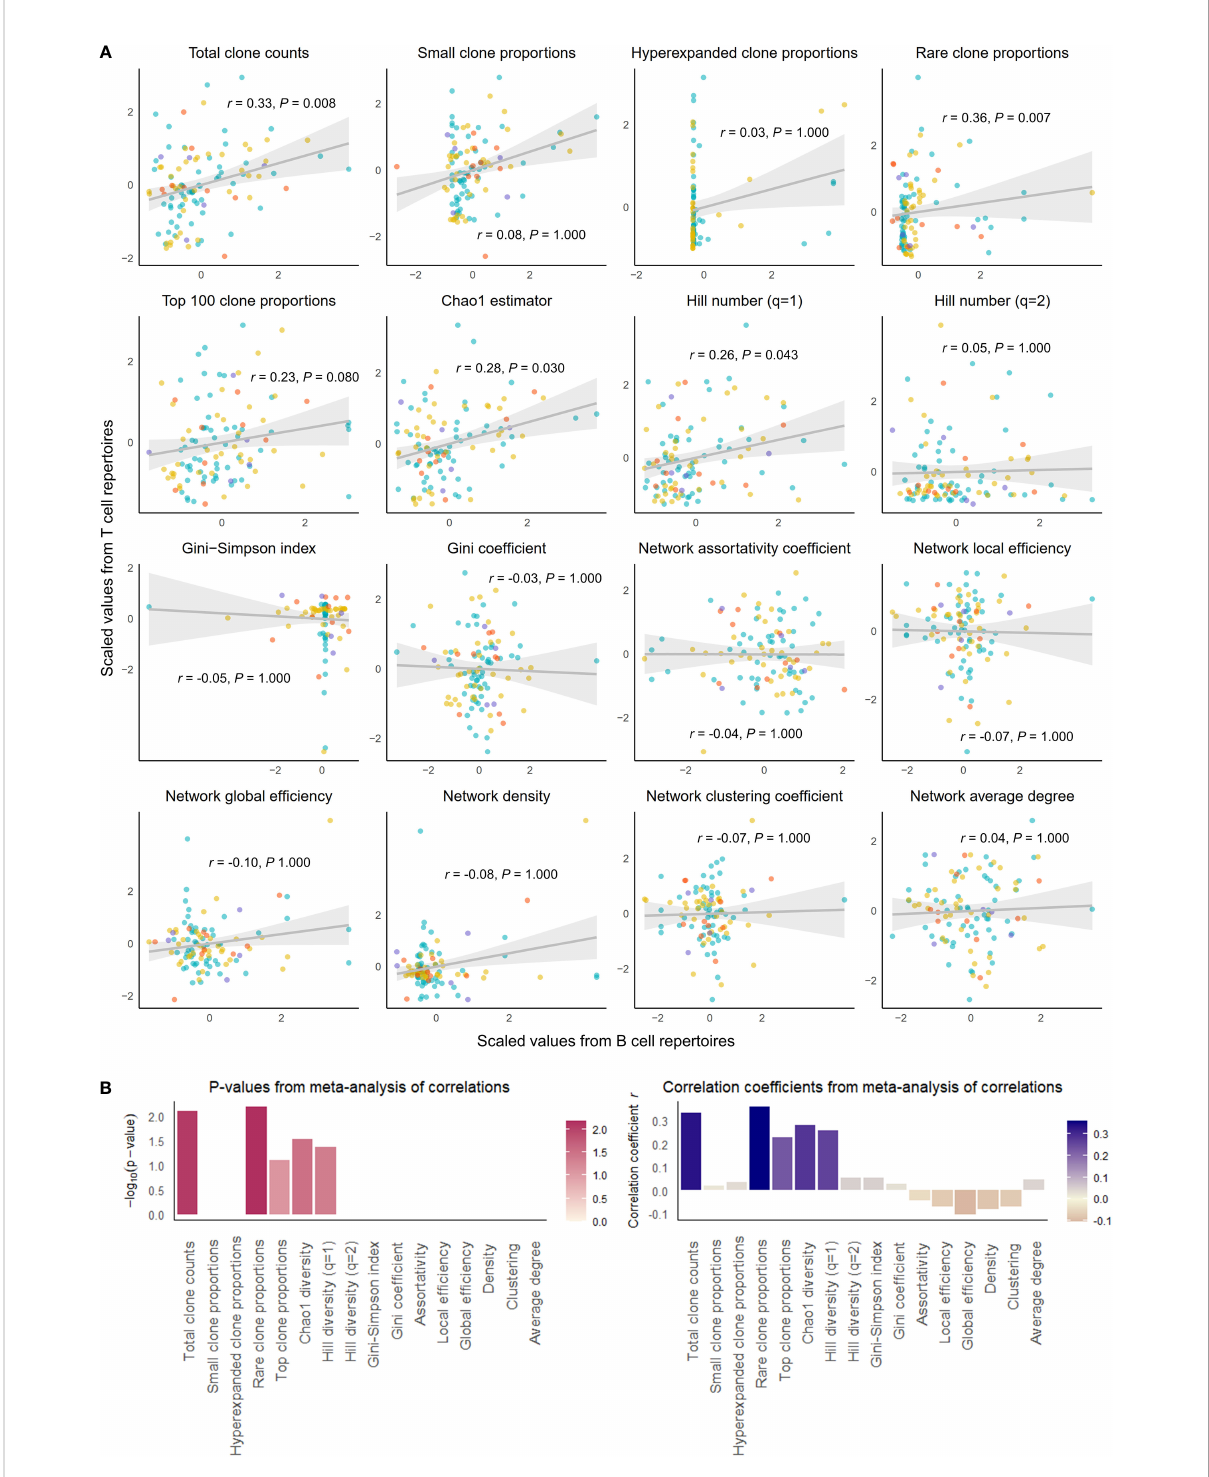
FIGURE 1 Correlation of select repertoire summary statistics between B and T cell repertoires of healthy individuals. (A) Scatterplot of scaled summary statistics for B and T cell repertoires of healthy individuals. Colors represent individuals from different studies. r and P values are derived from inverse variance-weighted fi xed-effects meta-analysis across all studies (B) Bar plots of P -values (left) and correlations coef fi cients r (right) from the meta-analysis of correlations for different summary